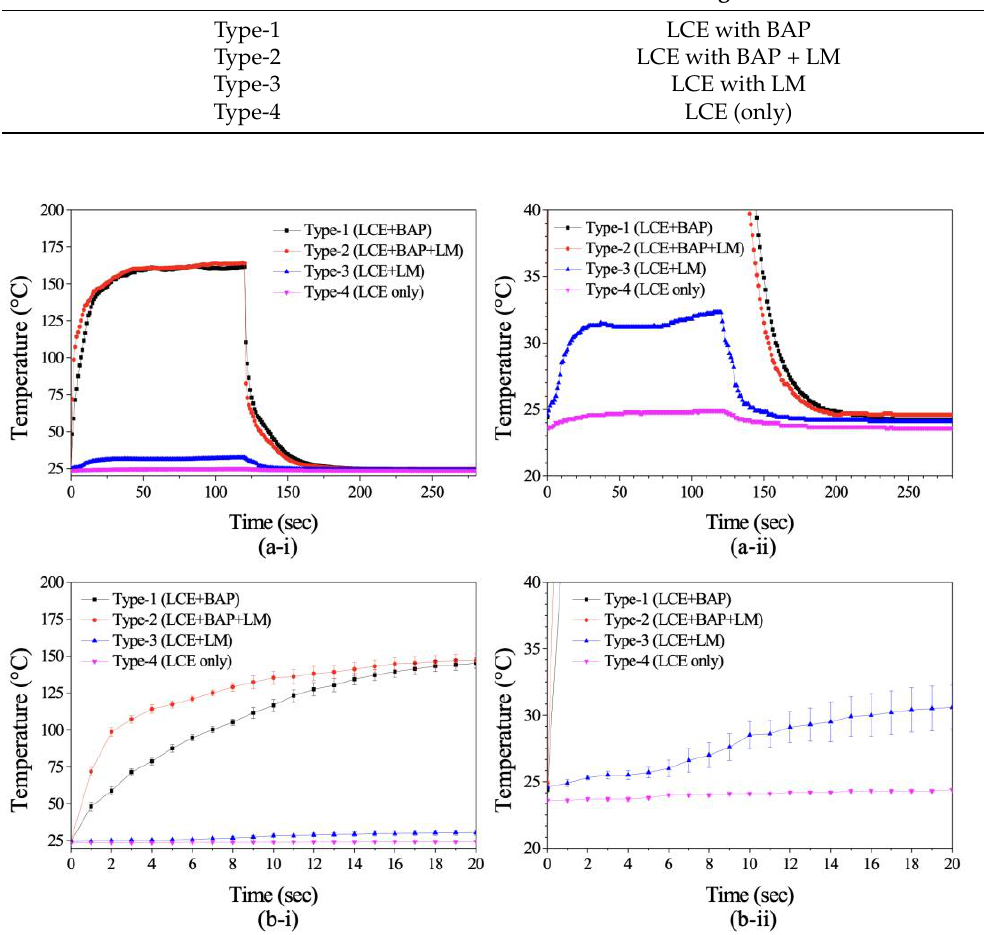
Figure 5. ( a - i ) Transient temperature responses of different types of LCEs heated by NIR light (808 nm, 2.4 W/cm2): ( a - ii ) The close-up figure of ( a - i ); ( b - i ) the close-up of ( a - i ); ( b - ii ) The close-up of 2.4 W/cm2): ( a-ii ) The close-up figure of ( a-i ); ( b-i ) the close-up of ( a-i ); ( b-ii ) The close-up of ( b-i ( b - i ).